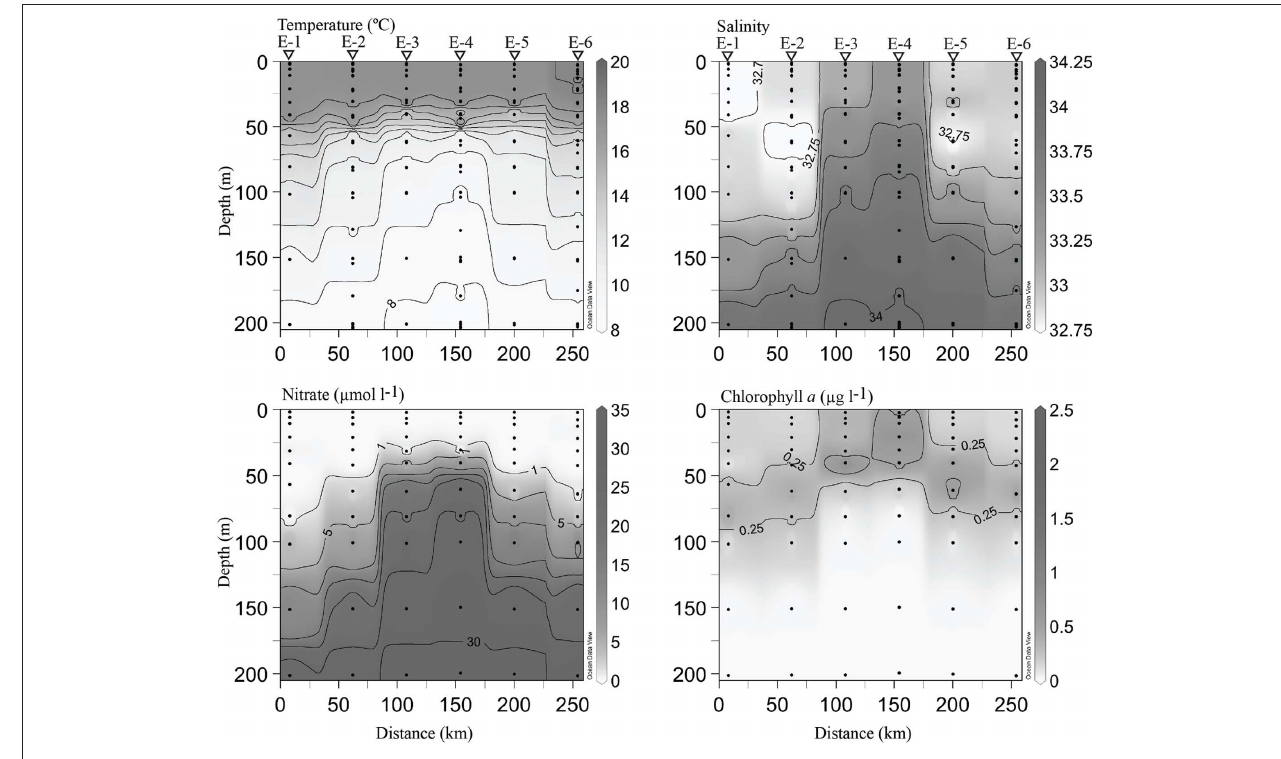
FiguRe 5 | Hydrographic conditions across a cyclonic eddy. Black circles indicate locations of discrete sampling. Contouring was generated as in Figure 4 . Triangles at the top of the plot indicate stations where DNA samples were collected. Eddy station names have been abbreviated with the letter E for